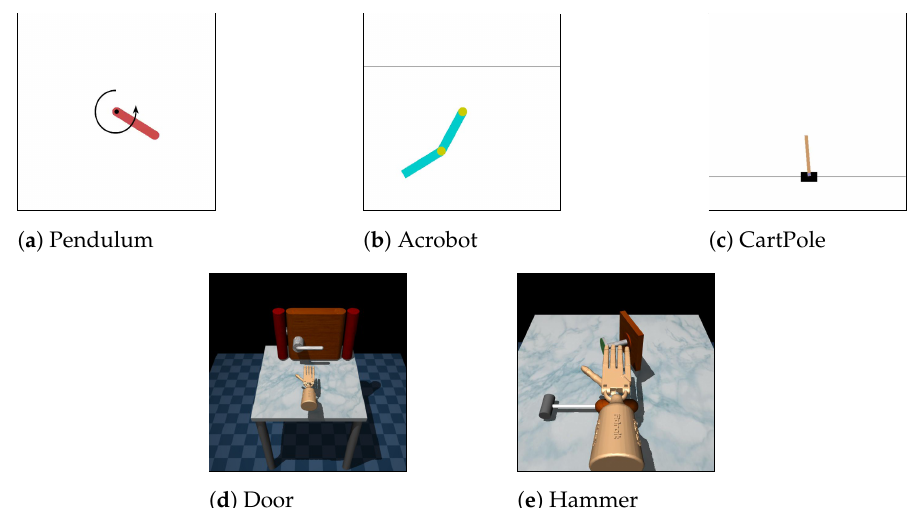
Figure 3. Visual rendering of five simulated environments used in our experiment.